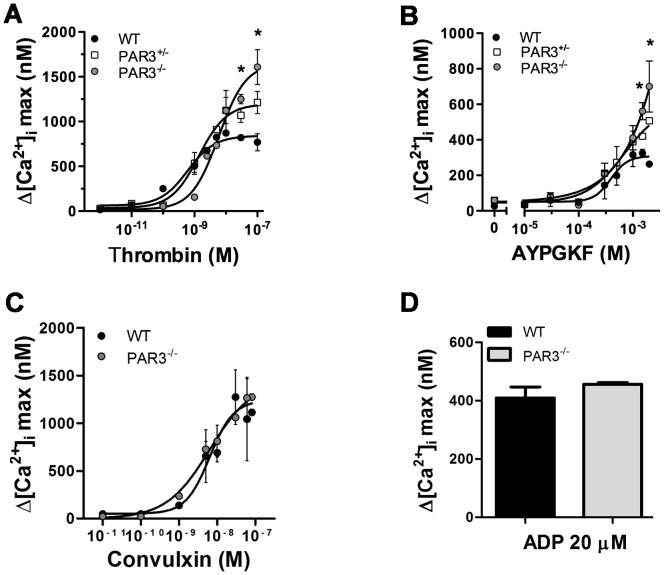
Dose response curve of Ca2+ mobilization in the presence of extracellular Ca2+ in mouse platelets.Fura 2-loaded wild type (black circle), PAR3−/− (gray circle), and PAR3+/− (white square) platelets were activated with the indicated concentrations of: (A) thrombin, (0.001–100 nM, (B) AYPGKF (0–2 mM), (C) convulxin (0.01–100 nM), or 20 µM of ADP for 10 min at 37°C in the presence of 2 mM of CaCl2. The difference between the maximum increase and the basal intracellular Ca2+ mobilization was measured. The results are the mean (± SD) of three independent experiments (* p<0.05).